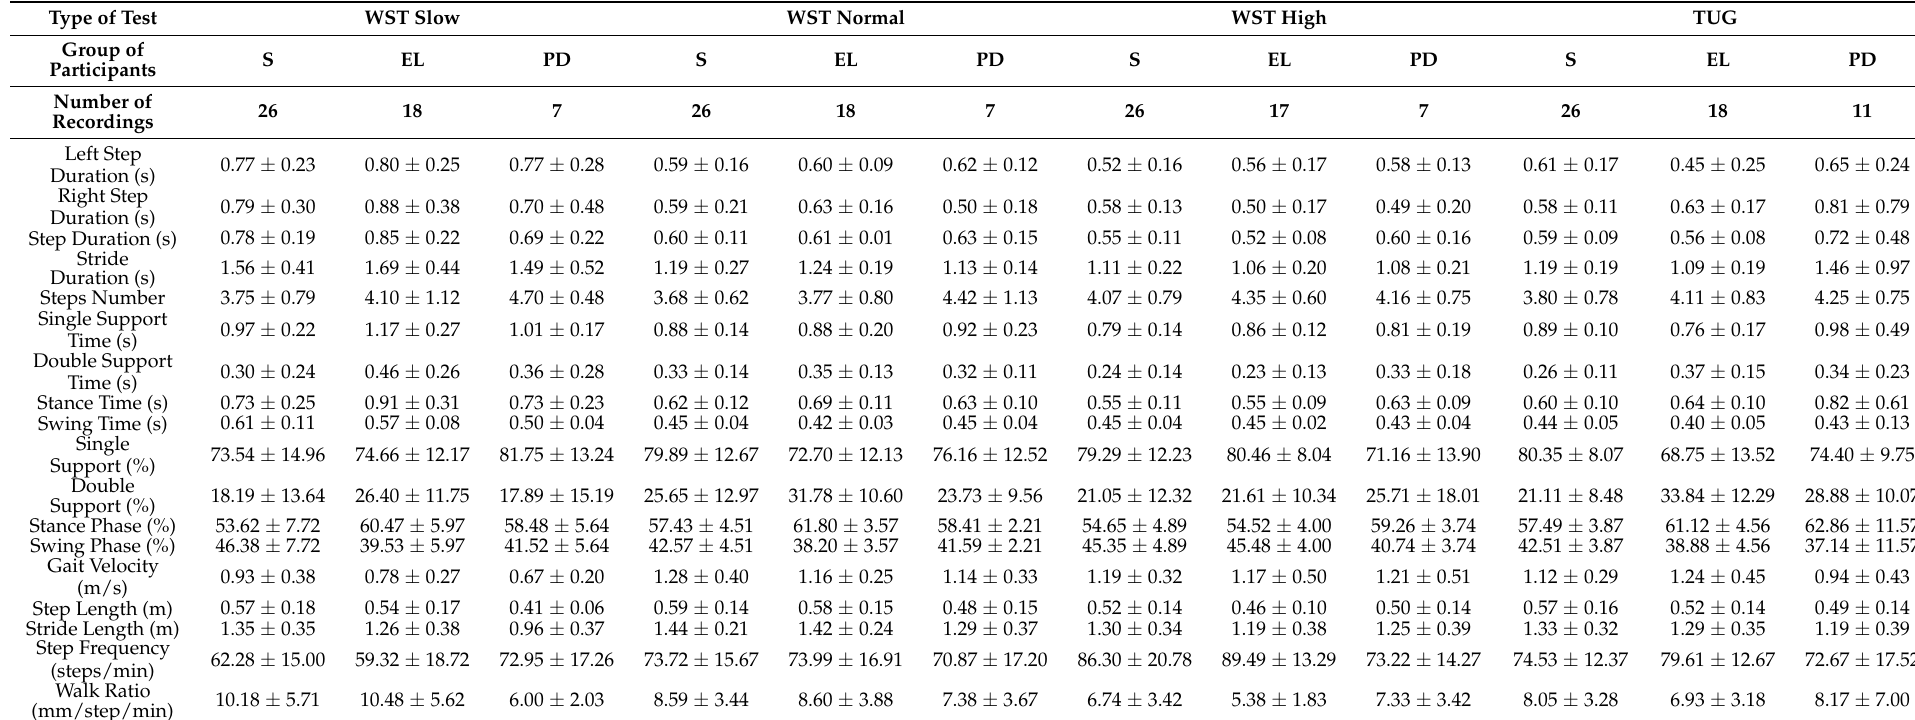
Table 7. Results on Turns (mean values along with standard deviations) of temporal and spatial characteristics using the Smart-Insole